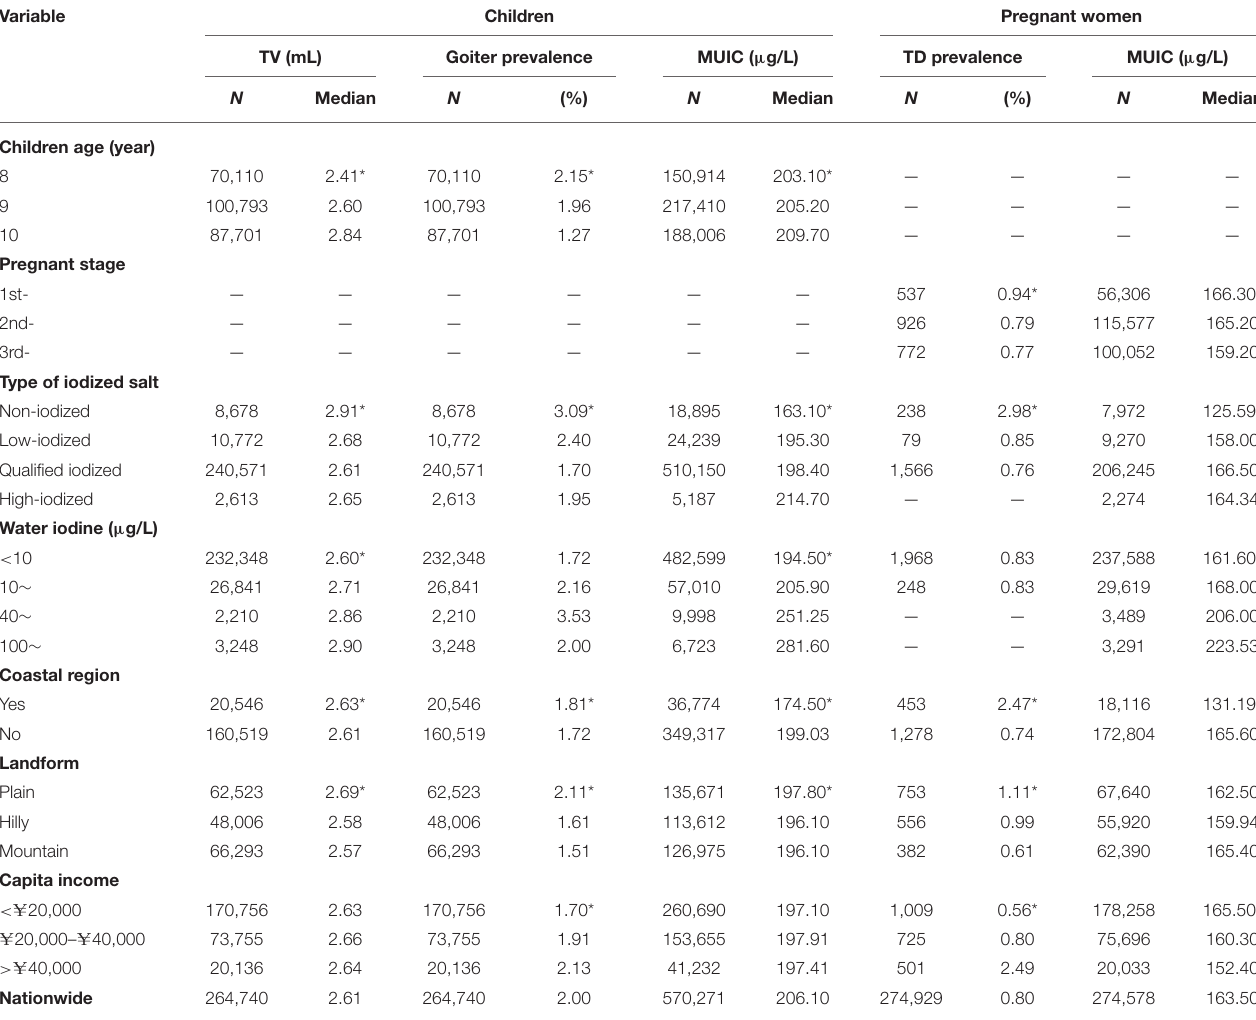
TABLE 1 | Descriptive data of the study